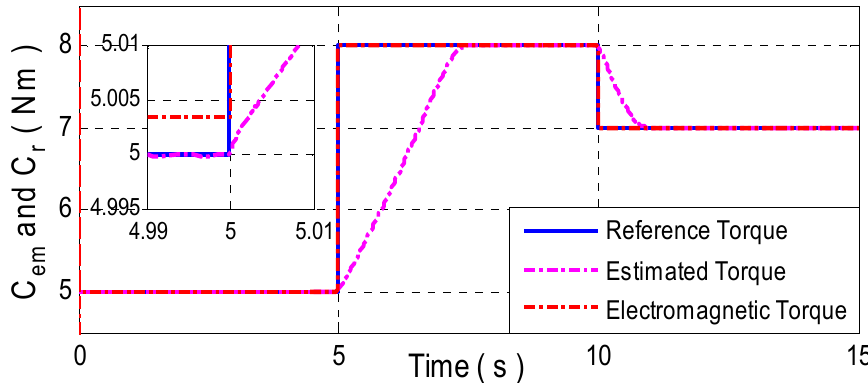
Figure 15. Estimated load torque, its reference value and electromagnetic torque.